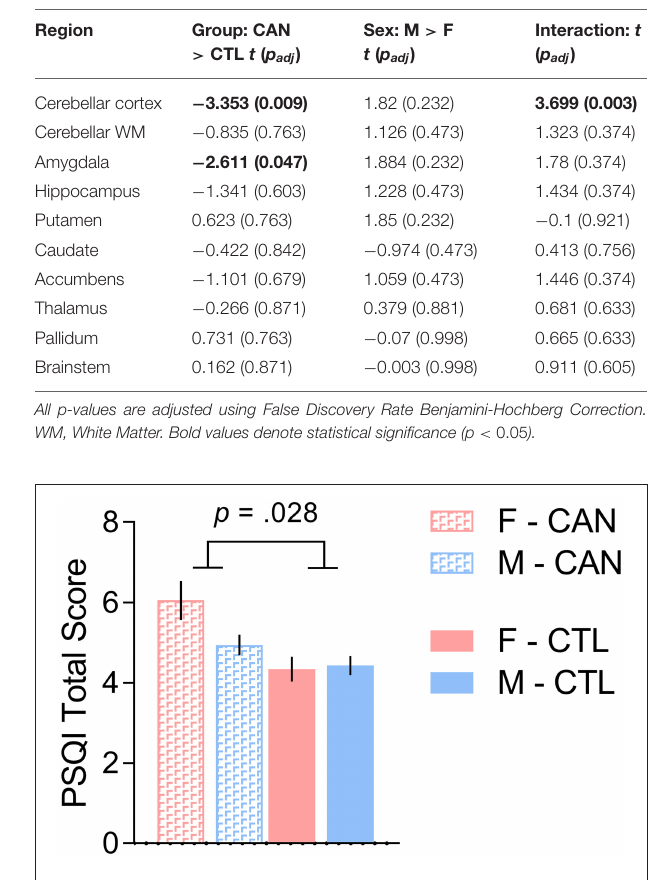
TABLE 2 | Summary statistics for analysis of subcortical regional volumes, showing: (1) the main effects of group, i.e., the chronic cannabis use group (CAN) vs. controls (CTL); (2) the main effect of sex, i.e., Males (M) vs. Females (F); and (3) their